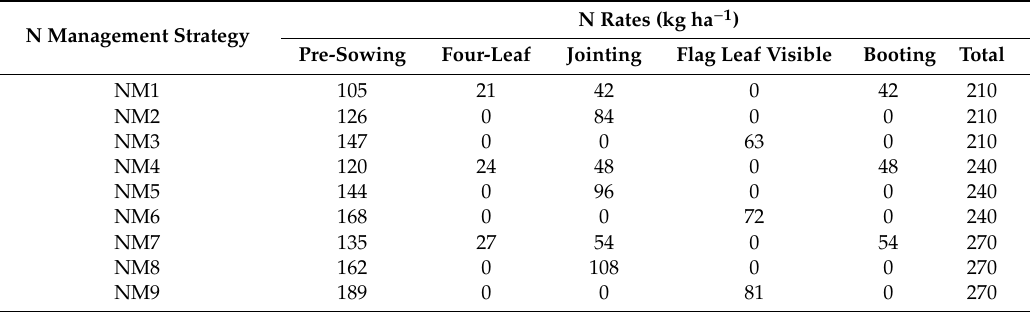
Table 2. Timings and rates of N application of di ff erent N management